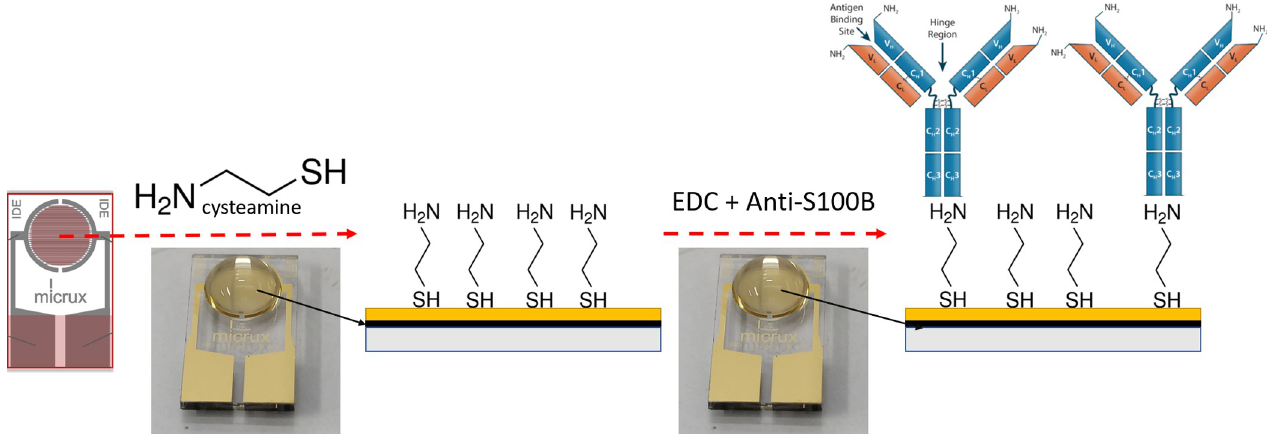
Fig 1. Graphical representation of the covalent immobilization of anti-S100B onto AUIDEs using a cysteamine/EDC approach.